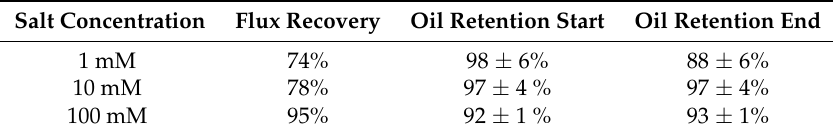
Table 1. Flux recovery and oil retention at 48 kg/h and 1 bar